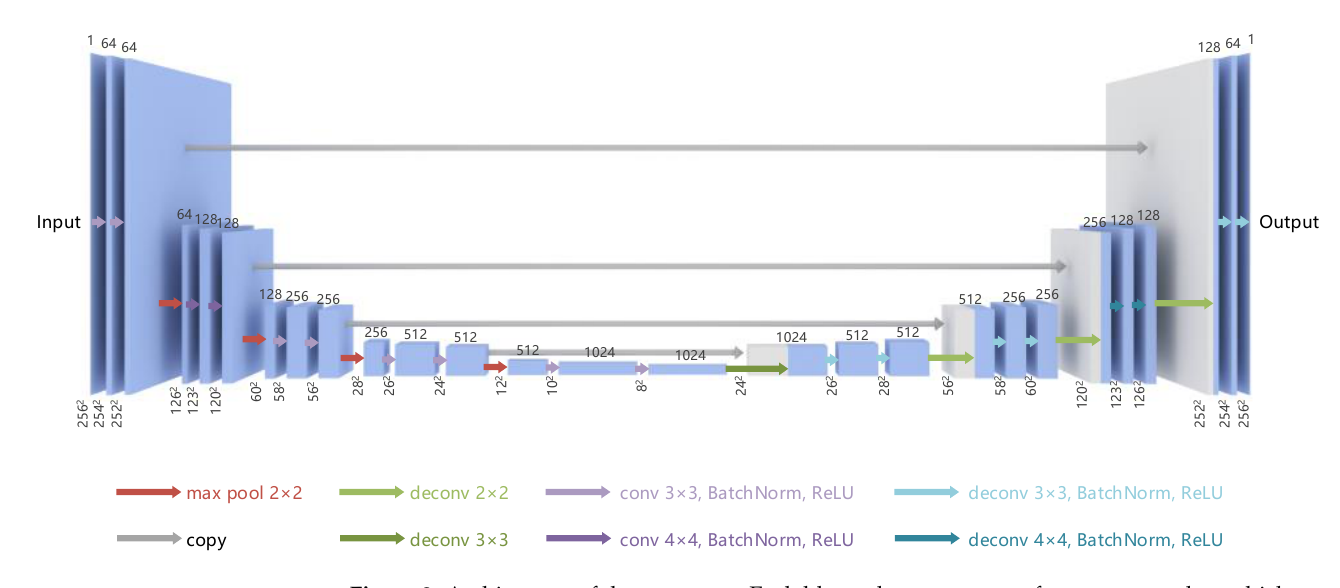
Figure 2. Architecture of the generator. Each blue cube represents a feature map, whose thickness (number on the top ) and size (number at lower left ) represent the channel number and the map size, respectively. The gray cube represents the copied feature map. The arrows in different colors represent specific actions to be performed on the feature